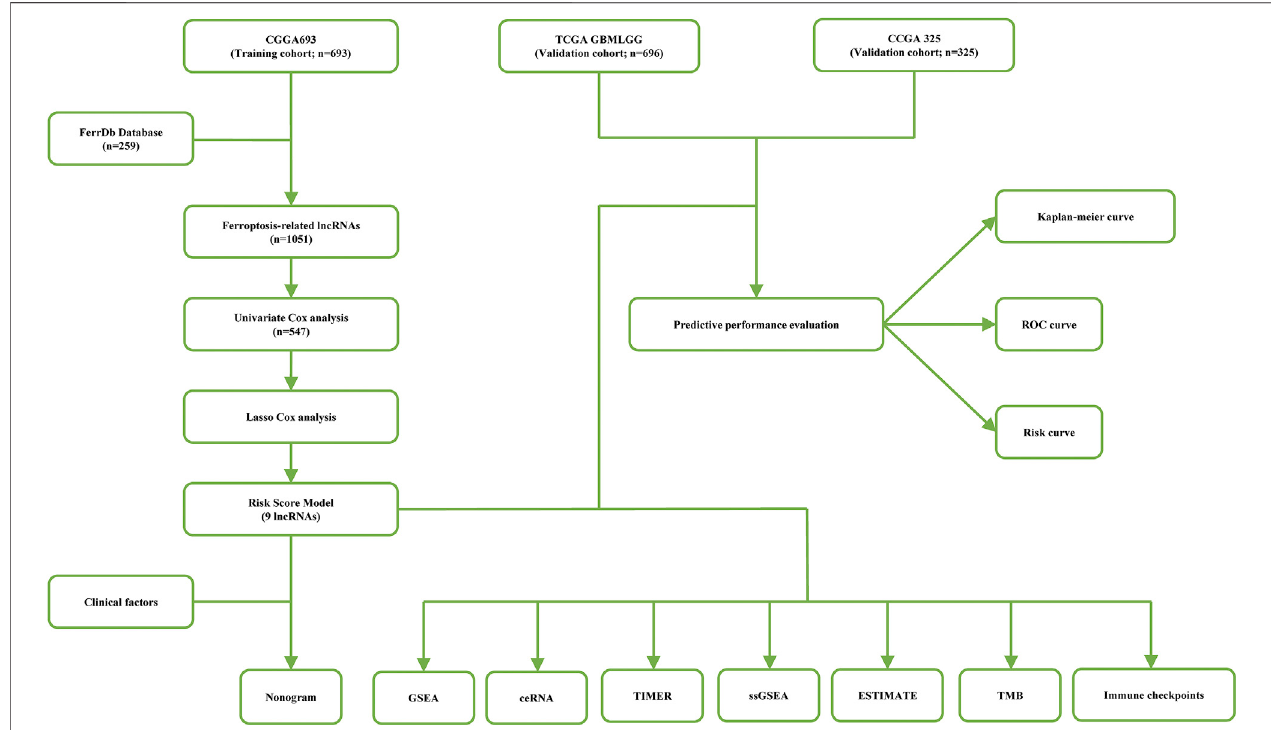
FIGURE 1 | A fl ow chart of data analysis methods and processing in this study.